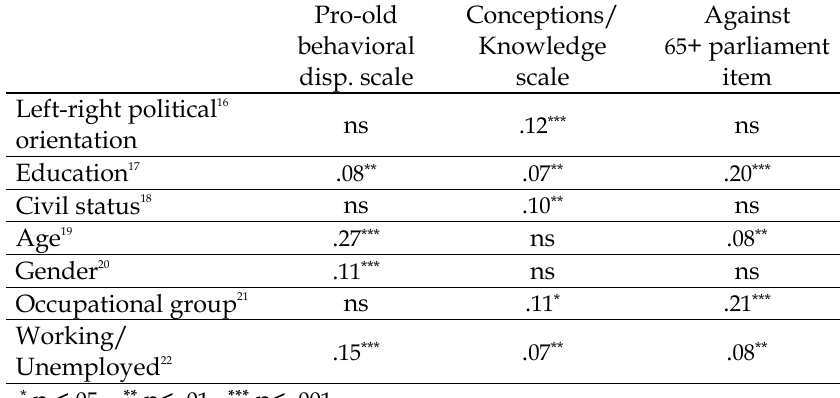
Table 2 . Eta-correlations between major measures and background vari- ables